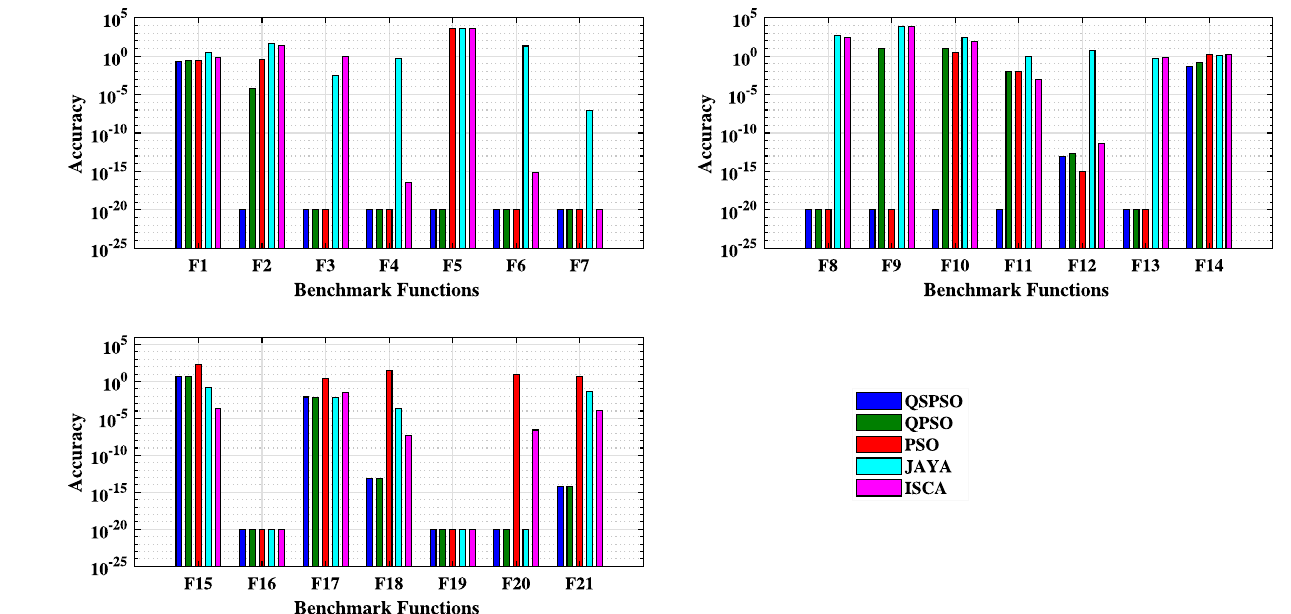
Figure 4. The accuracy comparisons among optimization algorithms. (For each test function, the bar graphs belong to QSPSO, QPSO, PSO, JAYA, and ISCA from left to right,